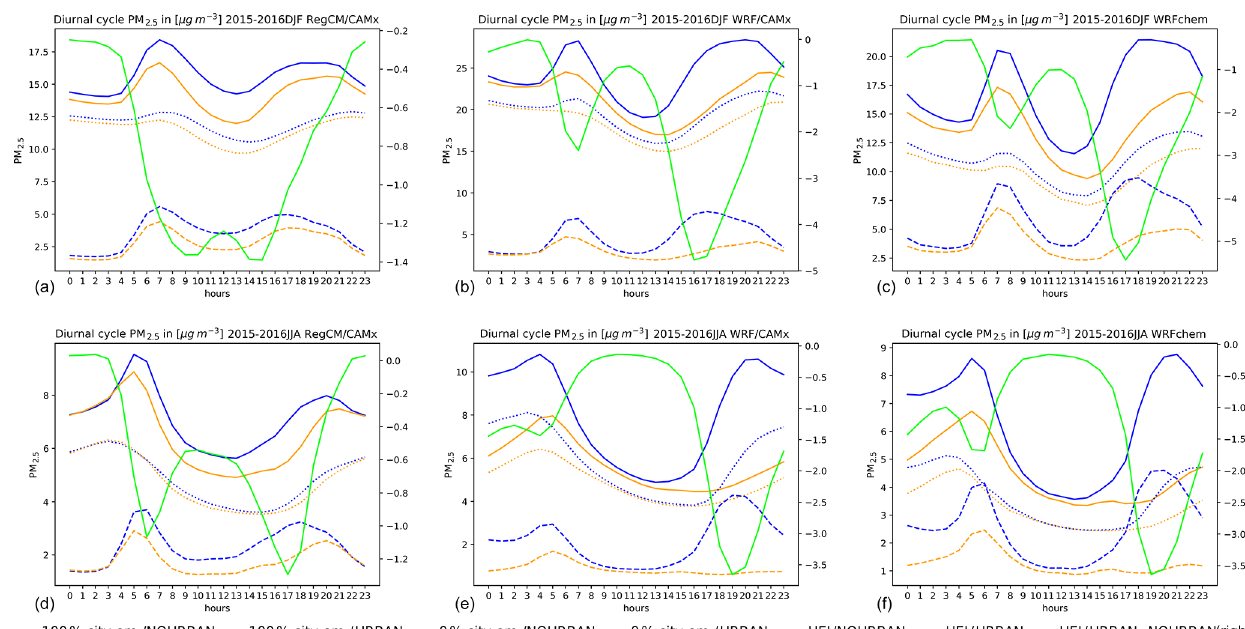
Figure 10. Same as Fig. 9 but for PM 2 . 5 (in µgm − 3